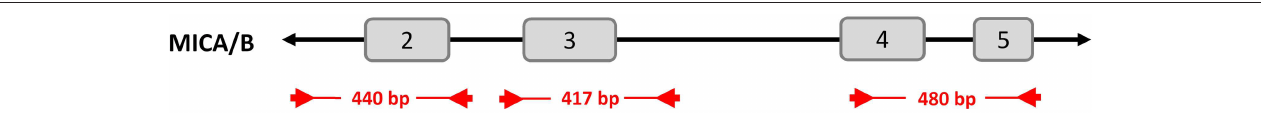
FIGURE 1 | Primer locations and PCR amplification products for exons 2–5 of MICA/B . Primers (arrows) bind to both MICA and MICB and generate three amplicons per gene in one PCR reaction. Product lengths are between 417 and 480 bp. Note that not all bases of exons 4 and 5 are covered.